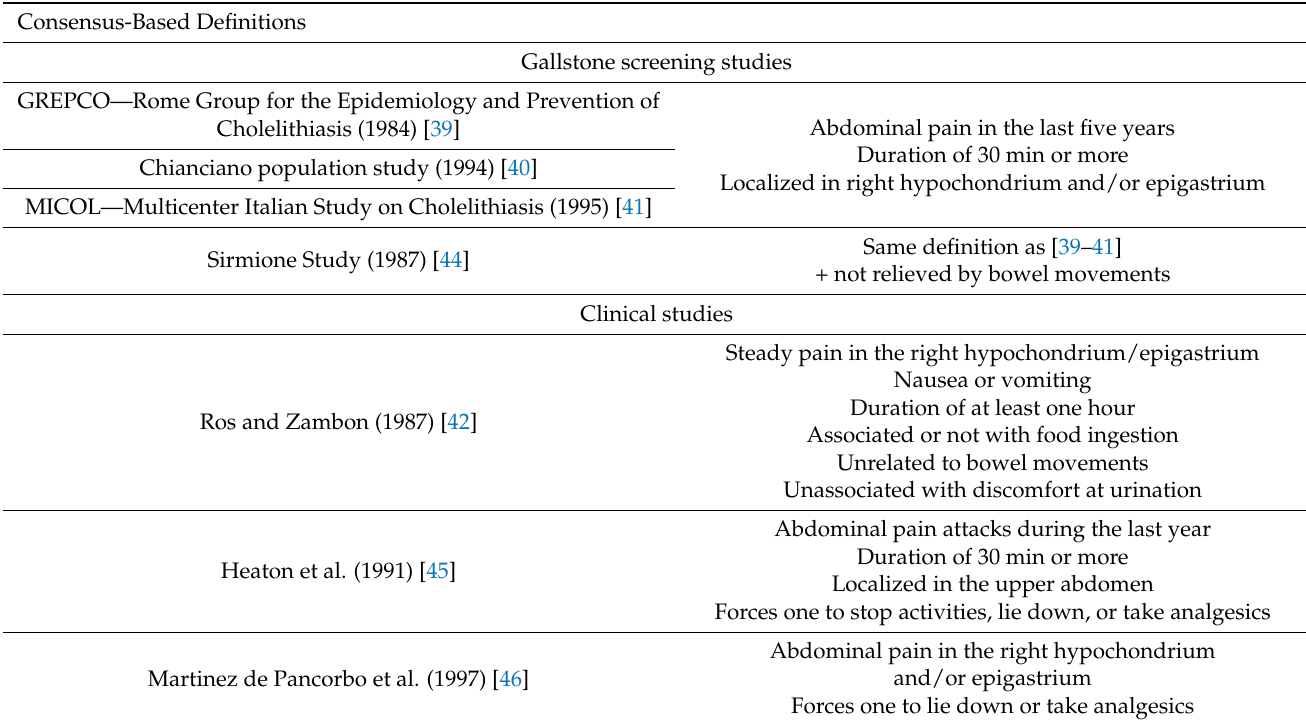
Table 1. Definitions of biliary pain in different types of